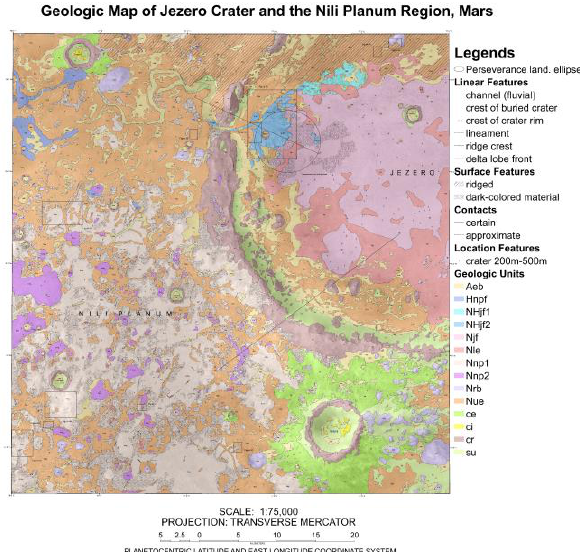
Figure 2. Mineralogical Map for Jezero crater (Nili Planum Region) and Perseverance landing site (Sun and Stack, 2020)